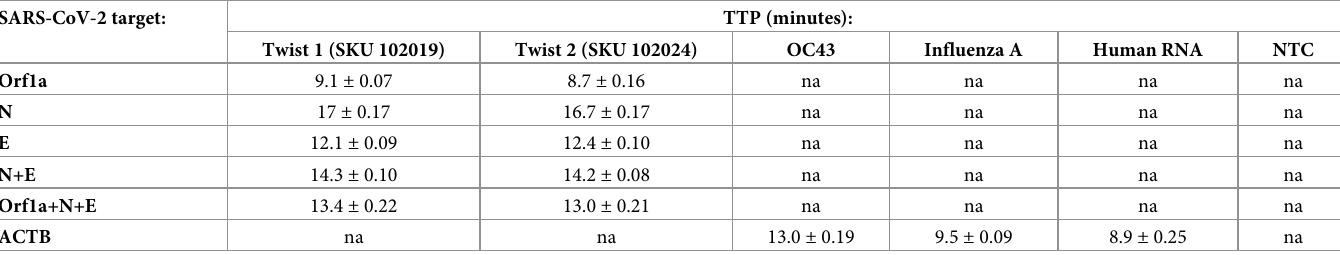
Table 1. RT-LAMP primer investigation.